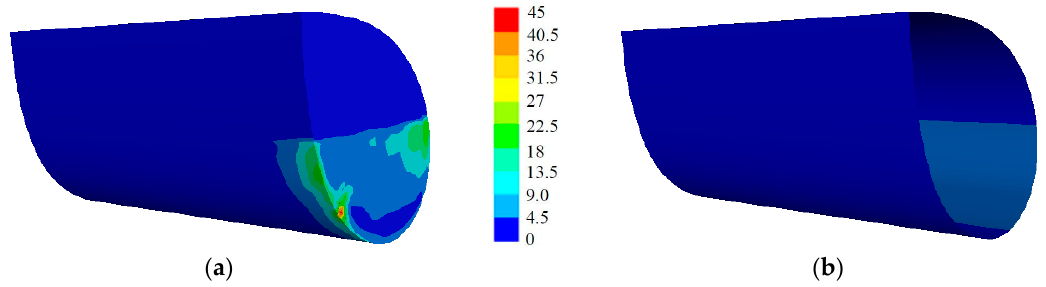
Figure 18. Comparison of dynamic pressure contour between 3D CFD and pseudo 3D CFD simulations at t = 8.544 s, when T = 1.6 s and H = 0.075 m: ( a ) 3D CFD; ( b ) pseudo 3D CFD.